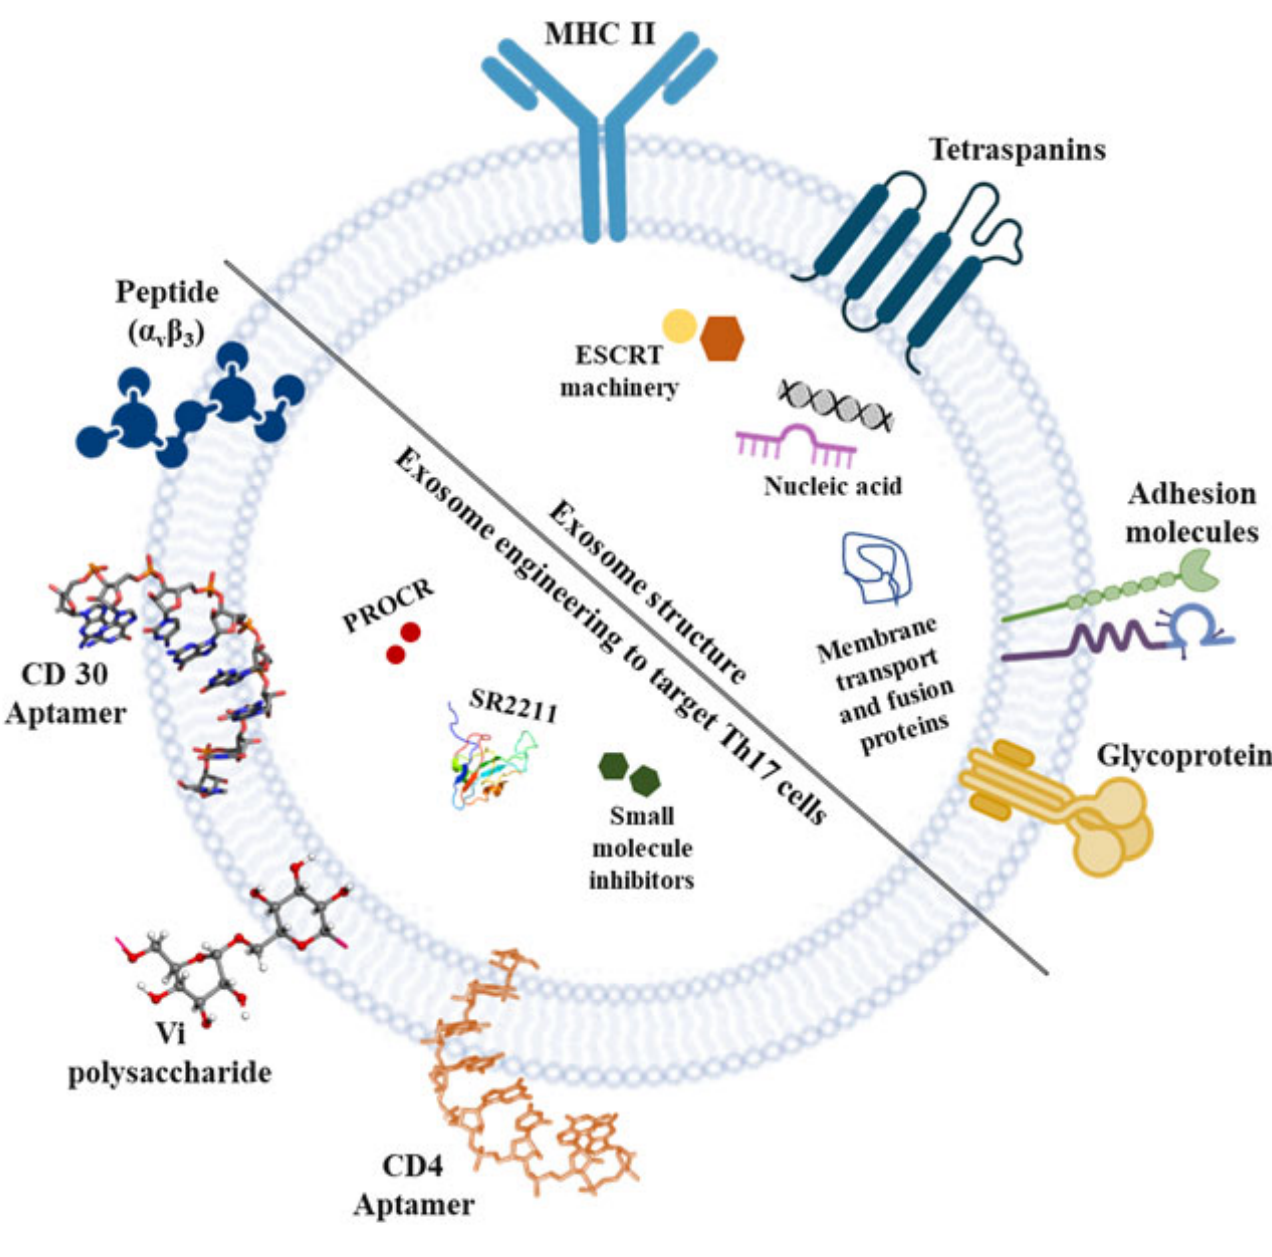
Figure 3. Diagrammatic illustration of exosome engineering for loading molecules into the lumen or sorting them on their surface for specific targeting of Th17 cells. Exosomes are engineered to express CD30 or CD4 aptamer, peptide targeting α v β 3 and Vi polysaccharide (targets prohibitins) on their surface using different sorting modules that result in a sustained response against Th17 cells. Furthermore, the packaging substances including drugs, nucleic acid molecules, etc., can be loaded onto the engineered exosomes for targeting Th17 cells to inhibit its pathogenic mechanism in diseases. Abbreviations: PROCR; protein C receptor, MHC; major histocompatibility